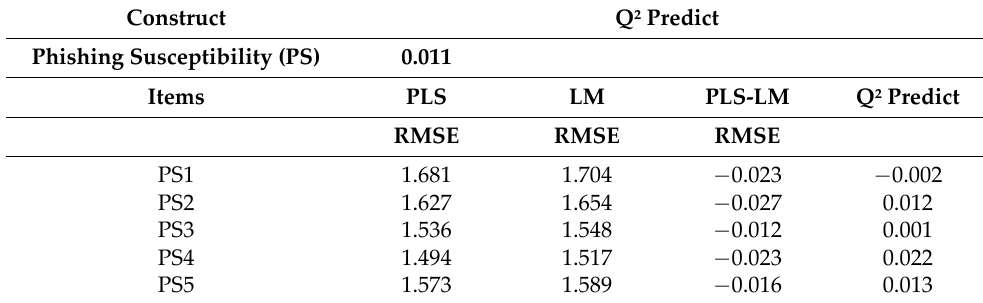
Table 7. PLS‑Predict